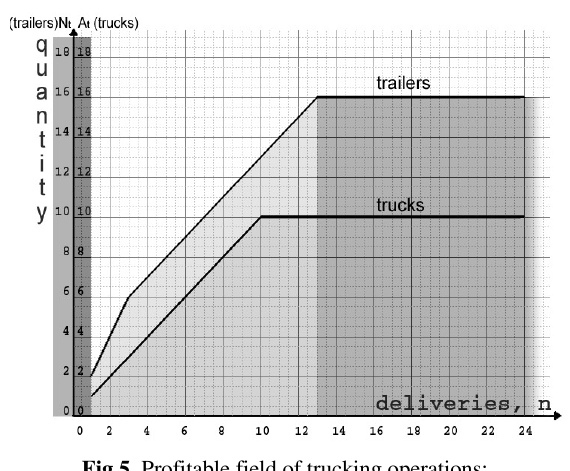
Fig 5. Profitable field of trucking operations: